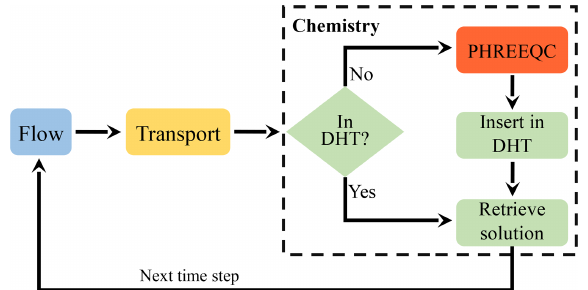
Figure 1. Schematic representation of sequential non-iterative ap- proach (SNIA) coupling of the three sub-processes flow, transport and chemistry. Distributed hash tables are filled at runtime with the results of “full-physics” chemical simulations, so that these can be reused at subsequent coupling iterations for similar chemical prob-